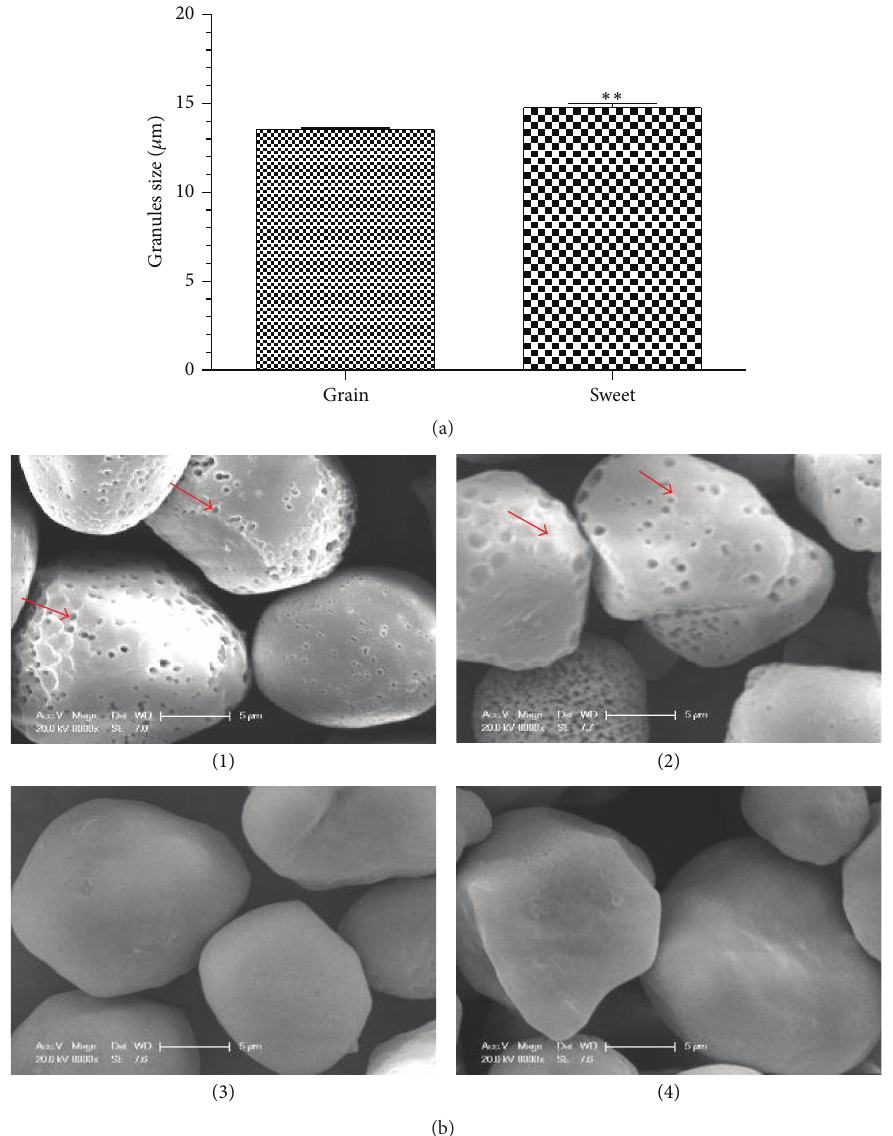
Figure 7: Comparison of starch granule size (a) and SEM images at magnification of 8000x (b) between sweet and grain varieties. ∗∗ means that high significant ( 𝑝 < 0.01 ) difference was noticed. In panel (b), 1–4 indicate GL-13, ST, TAT, and WAH, respectively.